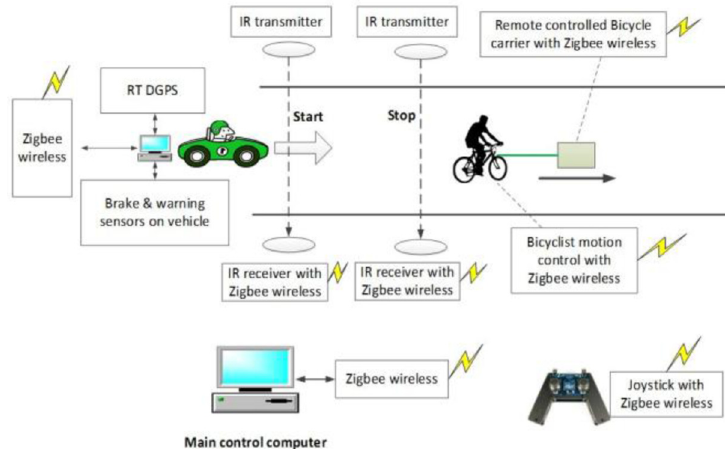
Figure 22 Overall test setup